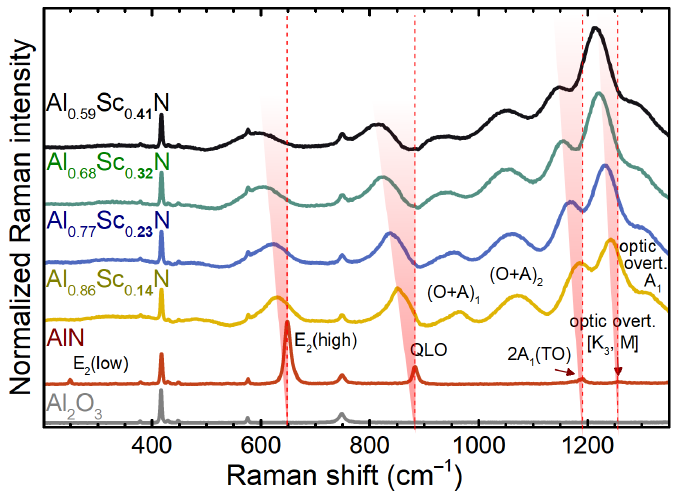
Figure 3. Raman spectra of AlScN films with various Sc concentrations. The spectra are stacked for clarity. The spectral bands of pure AlN are labelled by the dash lines to emphasise their low-frequency shifts in Al 1 − x Sc x N as a guide to the eye. The Raman spectrum of the Al 2 O 3 substrate revealed the bands unrelated to the nitride films.